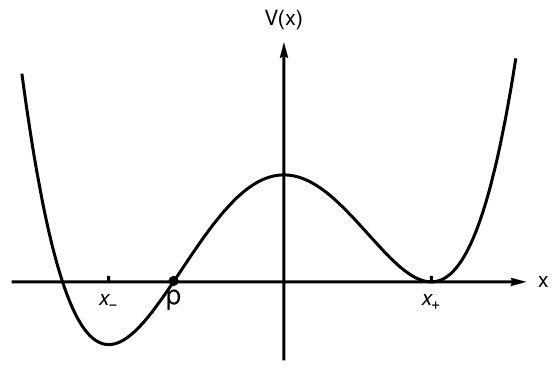
Figure 1 . The classical potential V ( x ) in a theory with a false